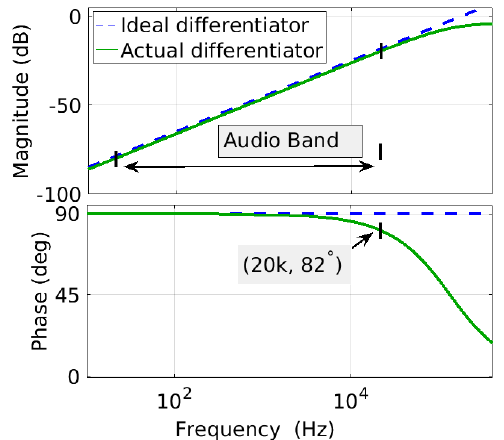
Figure 11. Magnitude/Phase versus frequency plot of ideal and practical